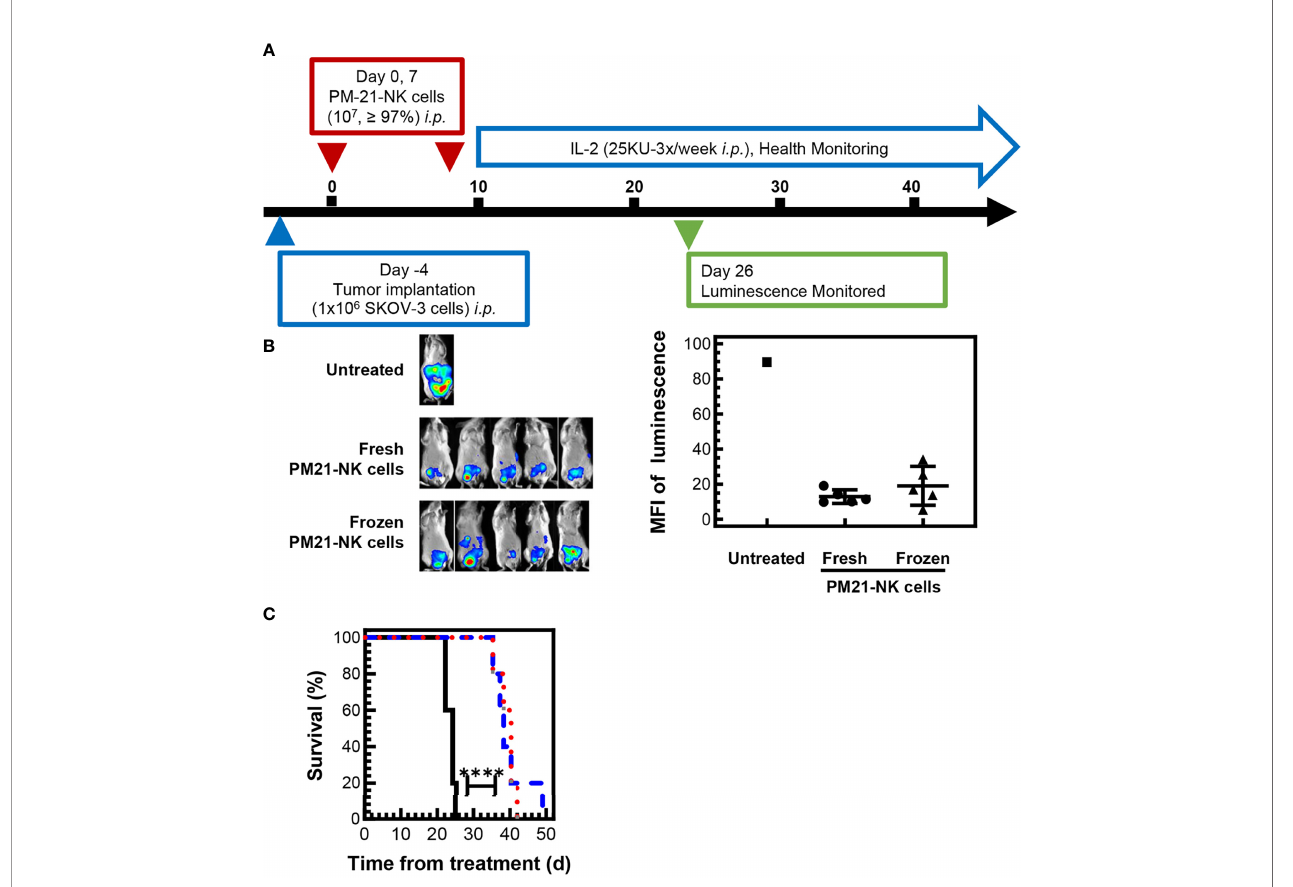
FIGURE 6 | Cryopreserved NK cells maintain antitumor effect in an in vivo mouse model. 1 × 10 6 SKOV-3-GFP-luc cells were injected to the intraperitoneal ( i.p. ) cavity of NSG (NOD-scid IL-2R g null) female mice and allowed to seed for 4 days. Mice were then treated with 2 doses of either fresh or cryopreserved NK cells that were thawed and directly injected i.p. along with IL-2 (25,000 U, 3×/week). Mice were imaged 26 days after the fi rst NK cell injection using In-Vivo Xtreme II imager and checked periodically for health status. A schematic of the experiment is shown (A) . Day 26 in vivo images (B) and quanti fi cation of luminescence (C) showed that mice treated with either frozen NK cells (triangles) or fresh NK cells (circles) had lower and comparable tumor burden based on the luminescence quanti fi cation compared to the signal measured in the only remaining untreated mouse (square). Mice injected with frozen NK cells (red dotted line) or fresh NK cells (blue dashed line) had a similar signi fi cant increase in survival compared to untreated mice (black solid line). Statistical signi fi cance was determined by Survival Curve comparison using the Gehan – Breslow – Wilcoxon